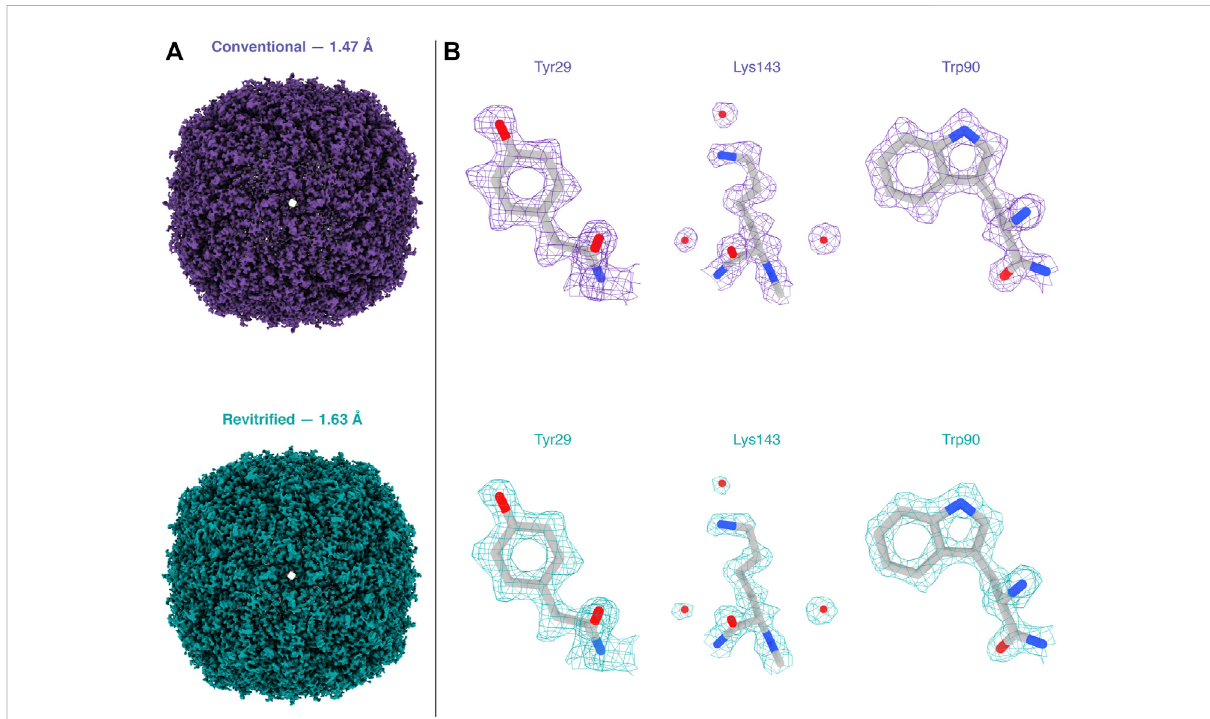
FIGURE 3 Reconstructions of apoferritin from conventional and revitri fi ed sample areas. Within the spatial resolution of the reconstruction, the structure of the particles is indistinguishable. (A) Reconstructions from conventional (purple, 1.47 Å resolution) and from revitri fi ed areas (green, 1.63 Å). (B) Details of the reconstructions, showing that the side chain denisities are clearly resolved and that single water molecules are visible. A molecular model of apoferritin (PDB 6v21 (Wu et al., 2020)) has been placed into the density through rigid body fi